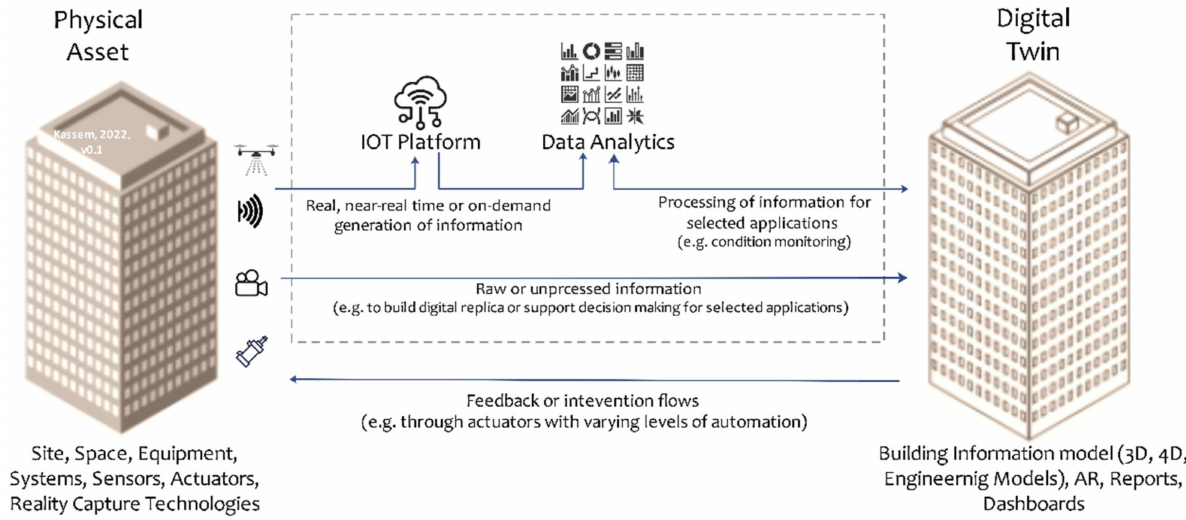
Figure 1. Essential components to create a digital twin of a building (adapted from ref. [9]). A comparison of the characteristics of BIM and digital twins is presented in Table 3 based on information derived from the literature. Table 3. Characteristics of BIM and digital twin as reported by different studies. Table 3. Characteristics of BIM and digital twin as reported by different studies. Table 3. Characteristics of BIM and digital twin as reported by different studies. Table 3. Characteristics of BIM and digital twin as reported by different studies. Table 3. Characteristics of BIM and digital twin as reported by different studies. Table 3. Characteristics of BIM and digital twin as reported by different studies. Table 3. Characteristics of BIM and digital twin as reported by different studies. Characteristics Table 3. Characteristics of BIM and digital twin as reported by different studies. Table 3. Characteristics of BIM and digital twin as reported by different studies. Table 3. Characteristics of BIM and digital twin as reported by different studies. Table 3. Characteristics of BIM and digital twin as reported by different studies. Table 3. Characteristics of BIM and digital twin as reported by different studies. Table 3. Characteristics of BIM and digital twin as reported by different studies. Table 3. Characteristics of BIM and digital twin as reported by different studies. Table 3. Characteristics of BIM and digital twin as reported by different studies. Table 3. Characteristics of BIM and digital twin as reported by different studies. Table 3. Characteristics of BIM and digital twin as reported by different studies. Table 3. Characteristics of BIM and digital twin as reported by different studies. Table 3. Characteristics of BIM and digital twin as reported by different studies. Table 3. Characteristics of BIM and digital twin as reported by different studies. Table 3. Characteristics of BIM and digital twin as reported by different